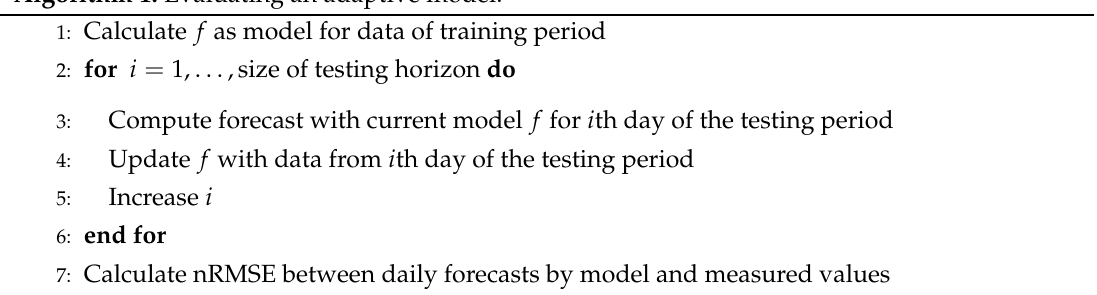
Algorithm 1: Evaluating an adaptive